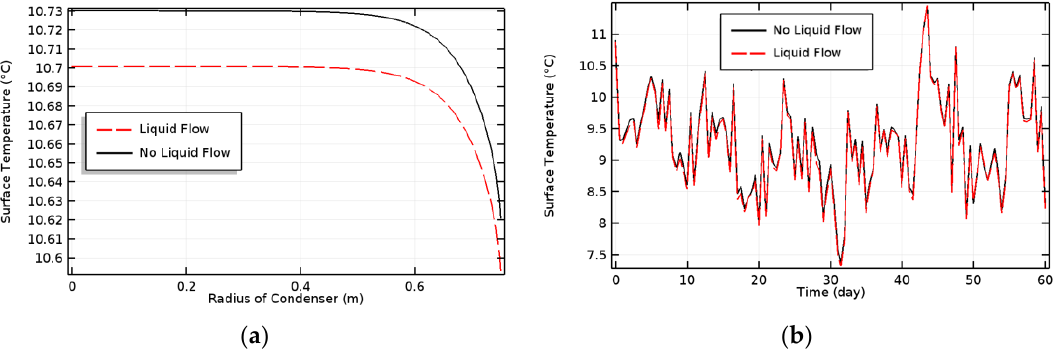
Figure 6. Comparison of GSHP modeling results for ( a ) steady-state analysis and ( b ) transient analysis (in two cases: liquid flow in the wick and without liquid flow).